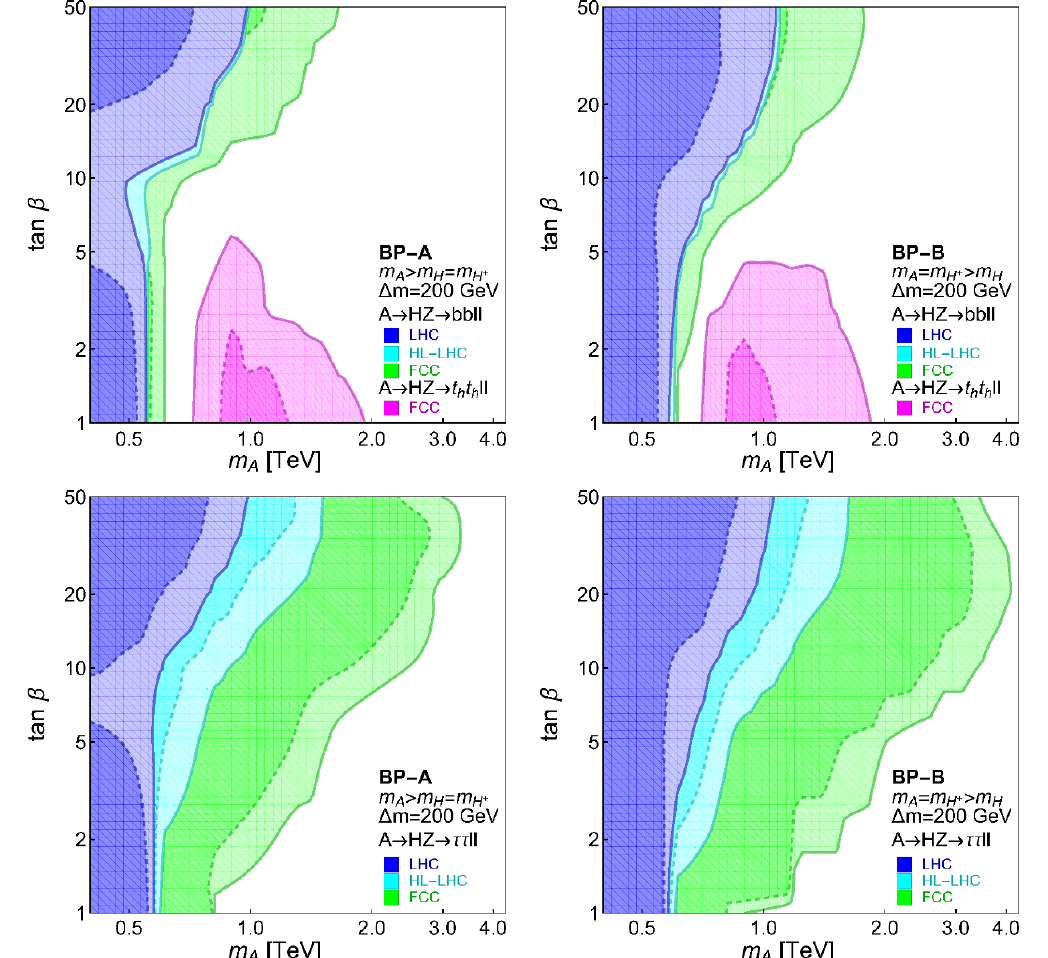
Figure 4 . Discovery (dashed) and exclusion (solid) reach for BP-A (left) and BP-B (right) at the LHC (blue), HL-LHC (cyan) and a 100 TeV pp collider (green and magenta) in the tan (cid:12) vs. m A plane for m A (cid:0) m H = 200 GeV. We show the reach for the bb‘‘ and t h t h ‘‘ channels (top), and (cid:28)(cid:28)‘‘ channel